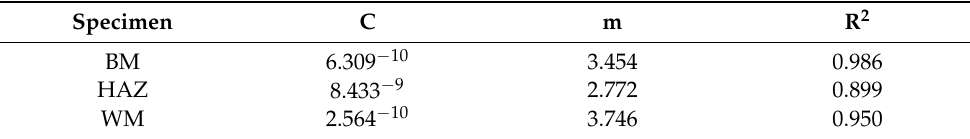
Table 3. Paris–Erdogan law parameters for different specimens.